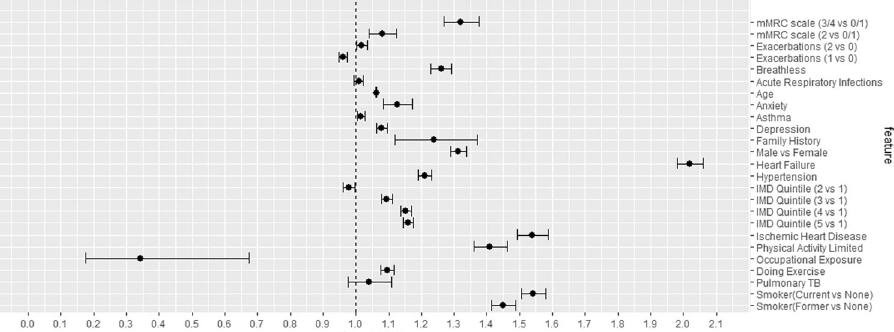
Fig. 4 Hazard ratio of various risk factors. Hazard ratio of various risk factors of all-cause mortality (within 10 years) for COPD patients with associated 95% con fi dence intervals (Supplementary information provides the hazard ratios of all the features, and additional details on how to apply the prognostic model to new patient